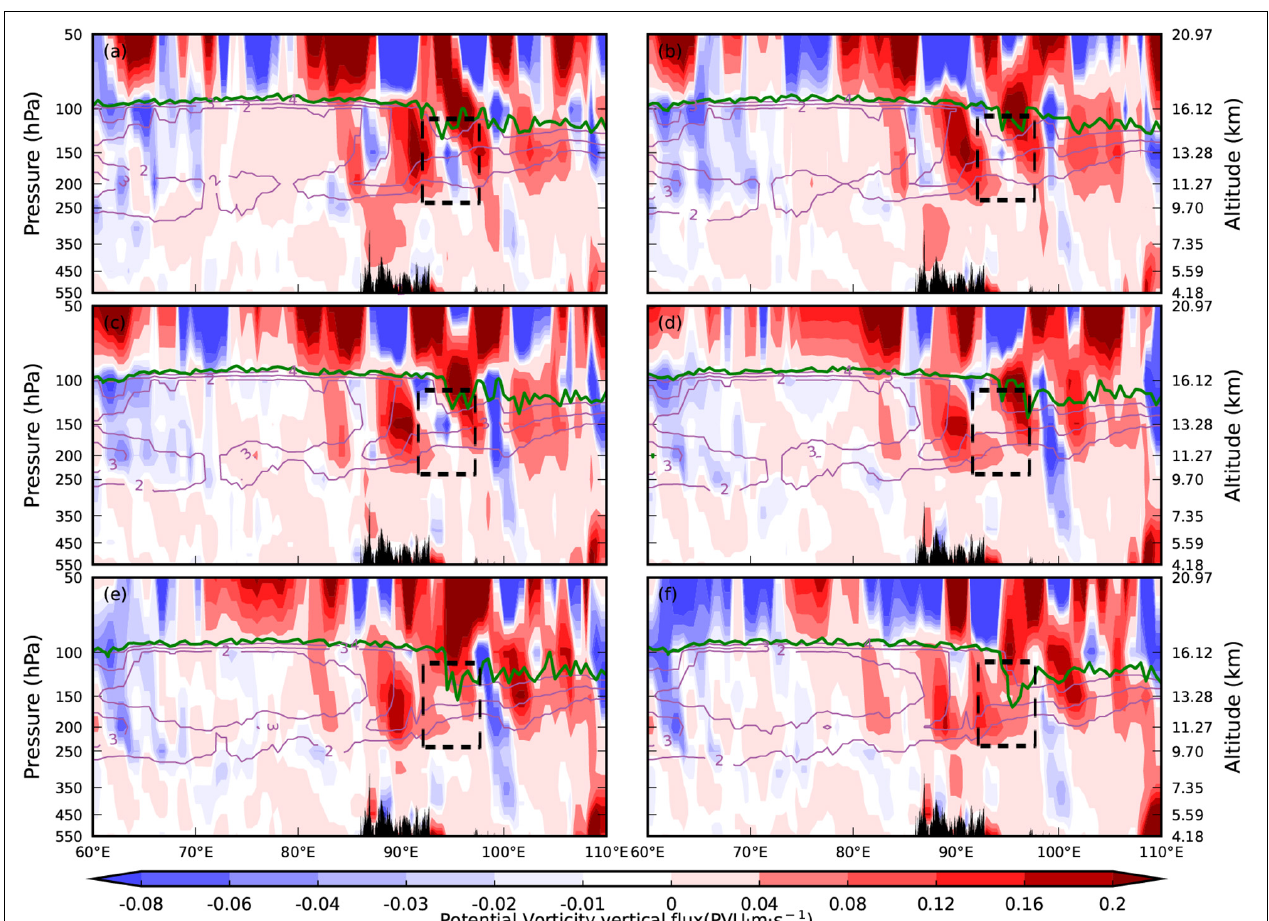
FIGURE 14 | Longitude–height cross section of the potential vorticity vertical flux (unit: PVU · m s − 1 ) along 28 ◦ N simulated by WRF. The solid green lines indicate the thermal tropopause and the solid purple lines indicate potential vorticity (unit: PVU). Times shown are (a) 18:20; (b) 19:20; (c) 20:20; (d) 21:20; (e) 22:20; and (f)